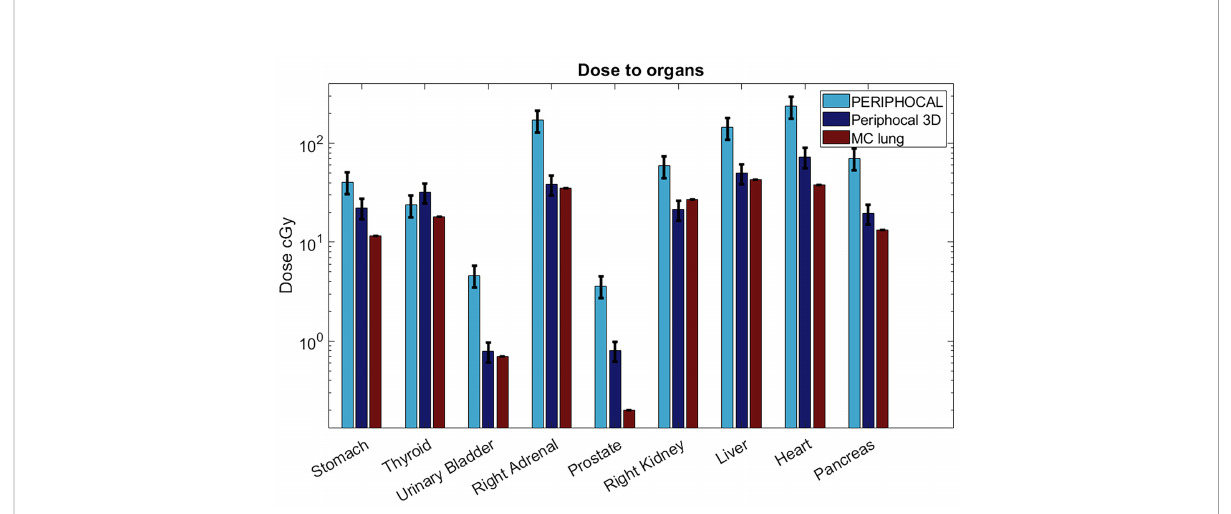
FIGURE 7 Absorbed dose to organs according to Periphocal 3D, PERIPHOCAL, and the MC simulation of the lung plan for the 60 Gy delivered to the isocenter. Error bars are presented as the uncertainty in each model (25% for PERIPHOCAL and 23.2% for Periphocal